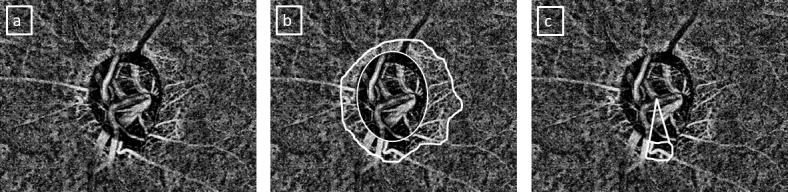
Evaluation of choroidal microvascular dropout (CMvD) in an eye with pseudoexfoliation glaucoma. (a) Choroidal slab of an optical coherence tomography angiography scan. (b) Optic disc margin (inner circle) and the region of parapapillary atrophy (outer outline) marked on the choroidal slab. (c) CMvD and the angular extent of CMvD marked on the slab.